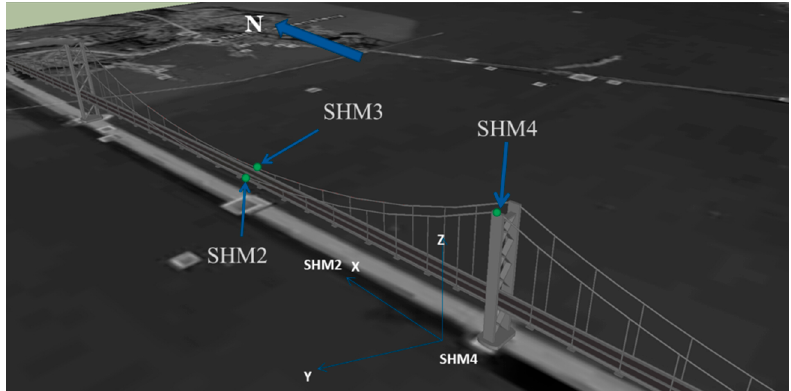
Figure 1. GNSS sensors and coordinate system definition.